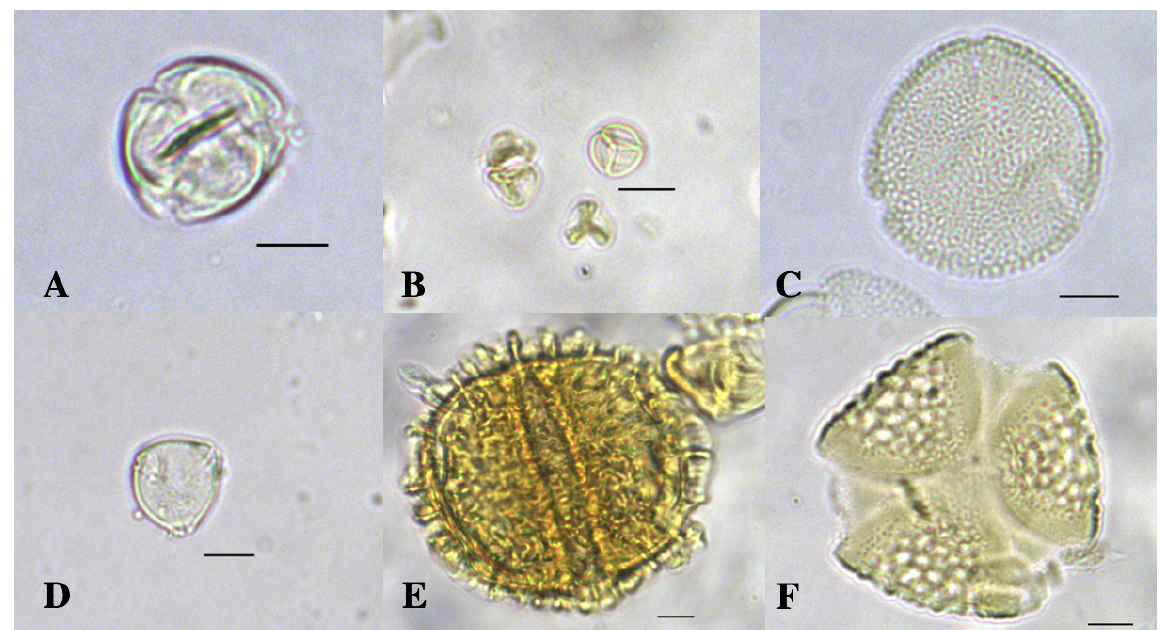
Fig 1 . Photomicrographs of certain pollen types observed in the nests of Euglossa females. (A) Solanum , (B) Mimosa pudica , (C) Zanthoxylum , (D) Eugenia , (E) Dalechampia and (F) Centrosema brasilianum (scale bars = 10 μ m).